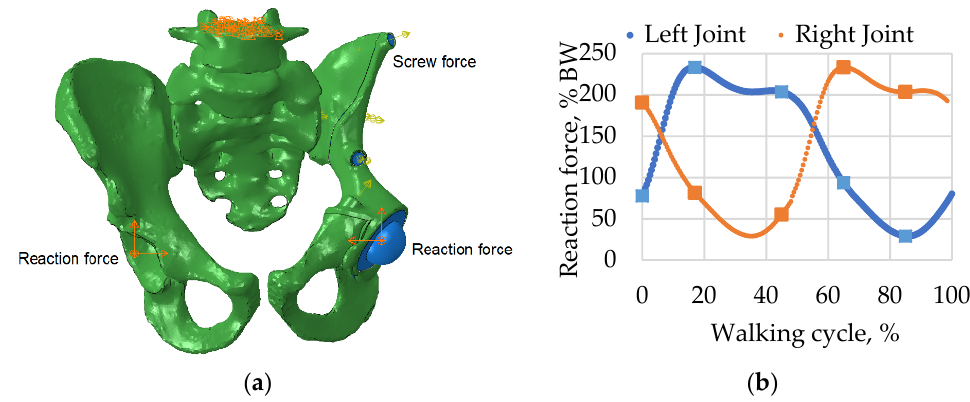
Figure 5. Boundary conditions and applied forces: ( a ) model with boundary conditions and loads including screw pretension and reaction forces applied to the centres of the left and right joints; ( b ) reaction force curves for walking simulation measured as a percentage of body weight (BW).